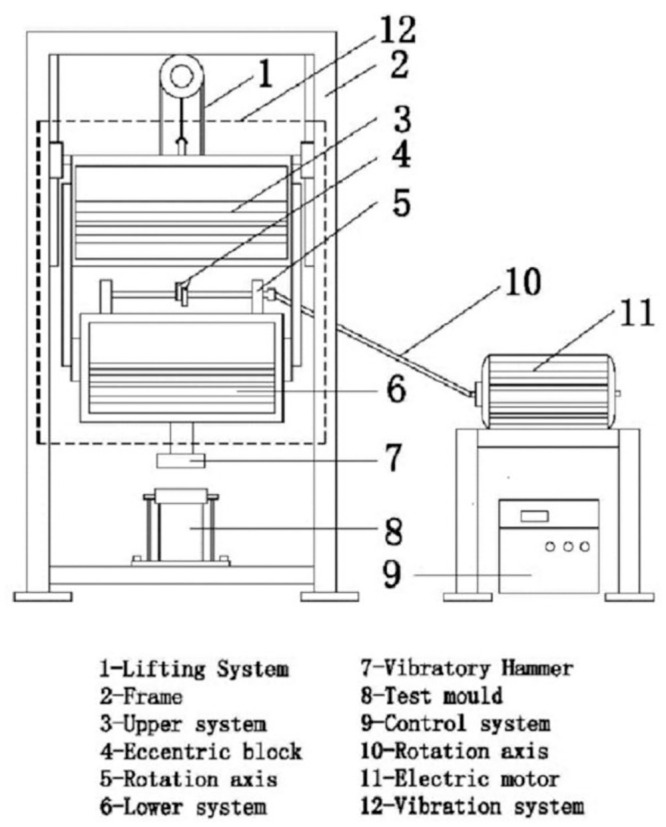
Schematic of VVTE.